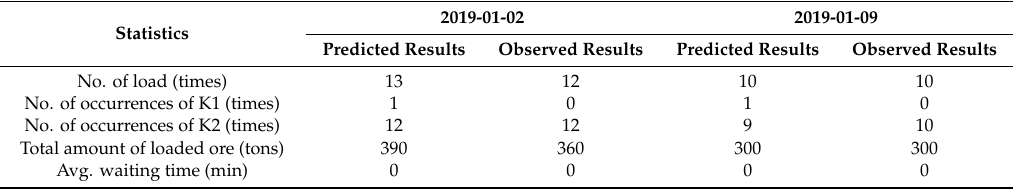
Table 6. Comparison of the simulation (predicted) results and the haulage operation results (observed) obtained on January 2 and 9, 2019.